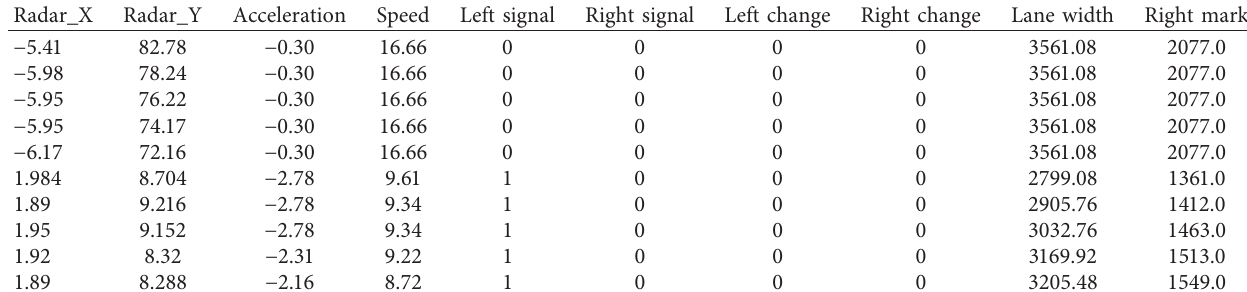
Table 4: The driving behavior features of the sample driving data.